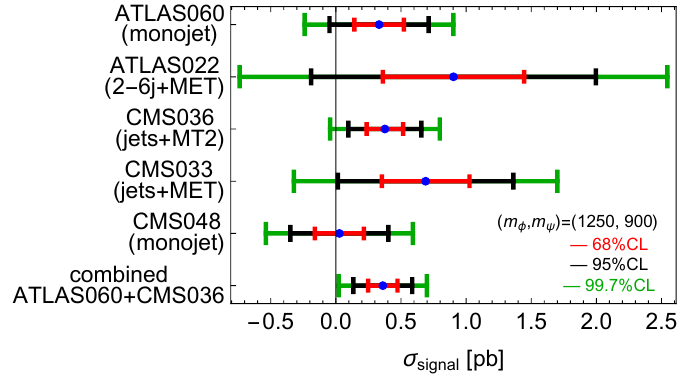
Figure 2 . Values of the signal cross sections favored at 1,2 and 3 (cid:27) by each individual search considered, and by the combination of ATLAS060 and